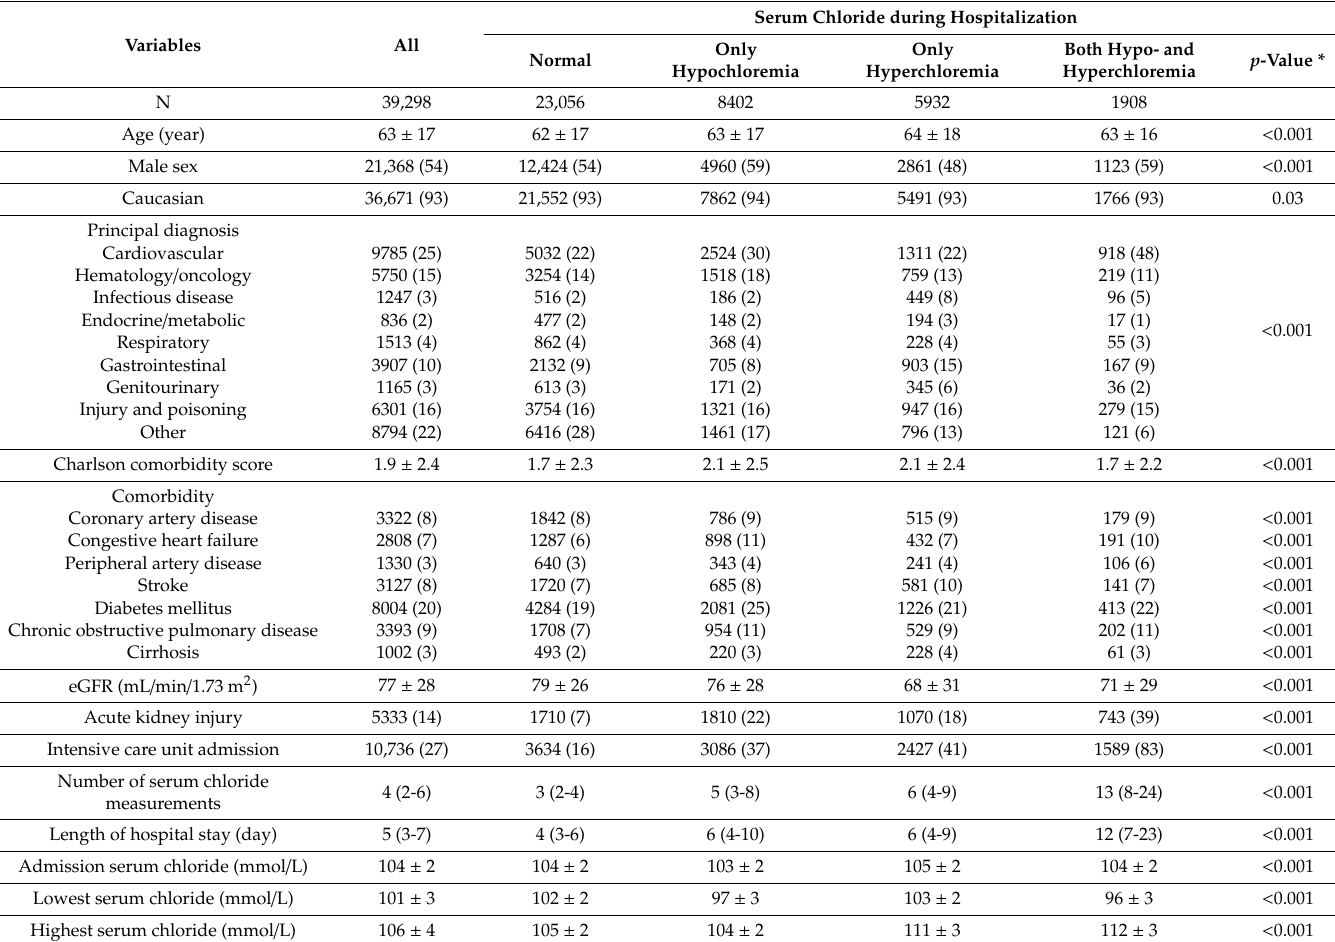
Table 1. Patient clinical